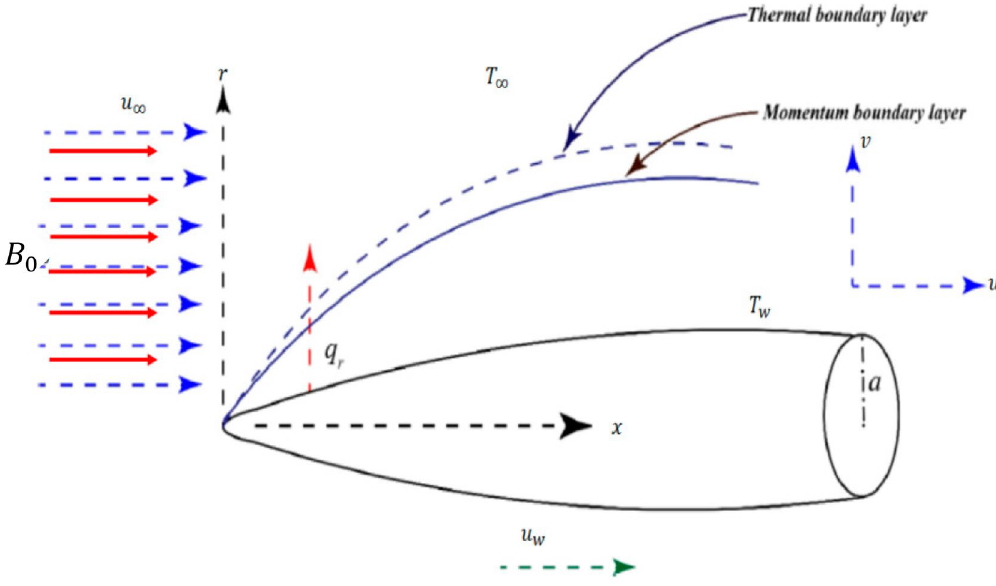
Figure 1. Schematic diagram for the given flow